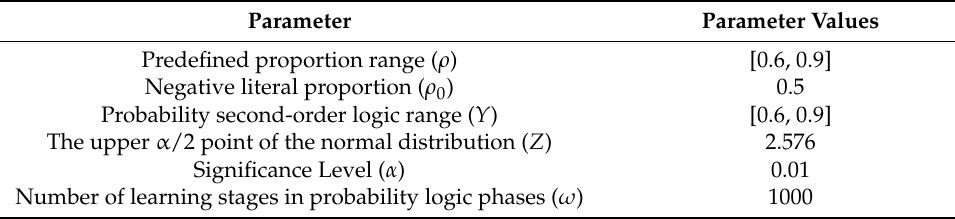
Table 2. Parameter list for probability logic phases.